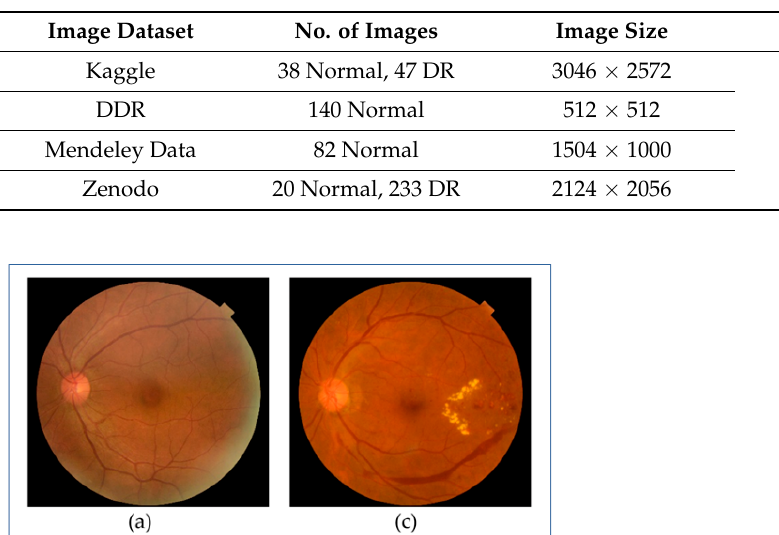
Table 1. Details of dataset.